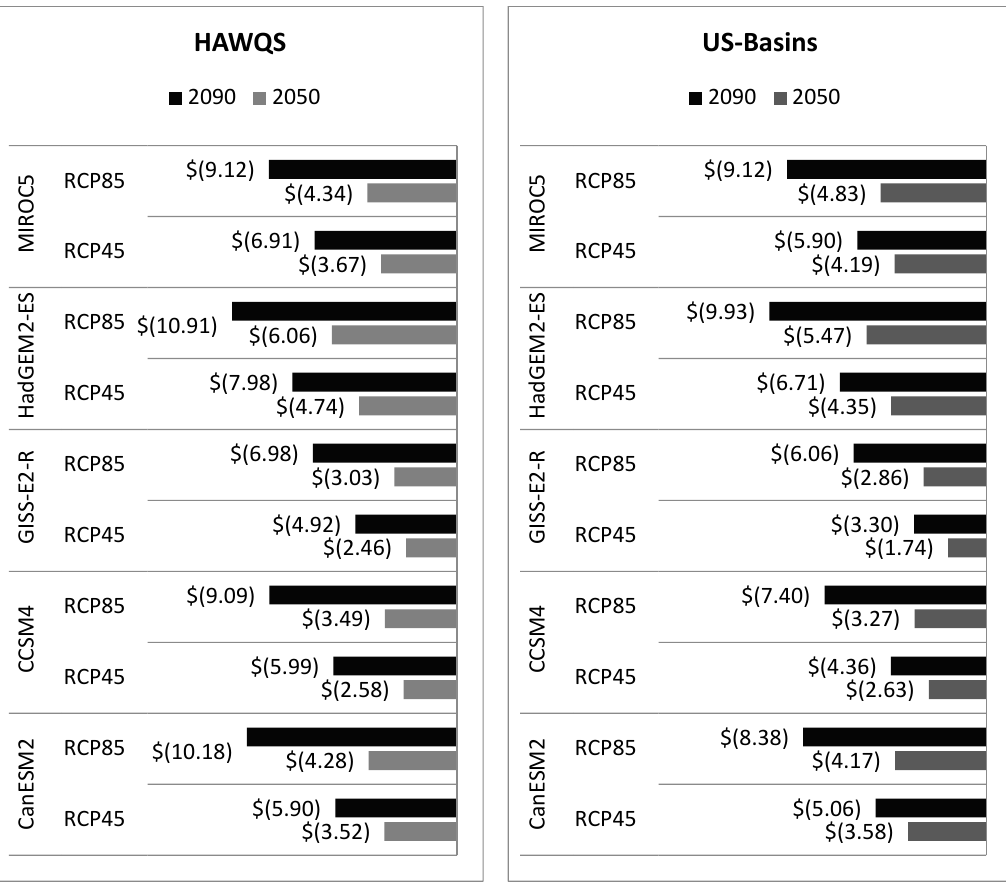
Figure 13. National willingness-to-pay (WTP) (USD/person/year) for HAWQS ( left ) and US-Basins ( right ) for all five General Circulation Models (GCMs). Table 4. Total WTP (in billion 2005 USD/year) for all five GCMs and global GHG mitigation scenarios.